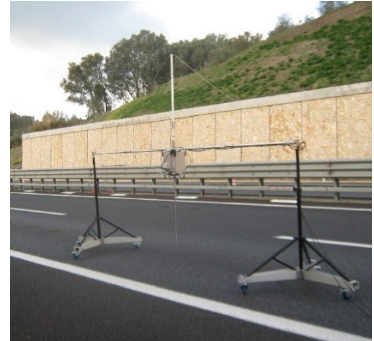
Figure 3: ADRIENNE method